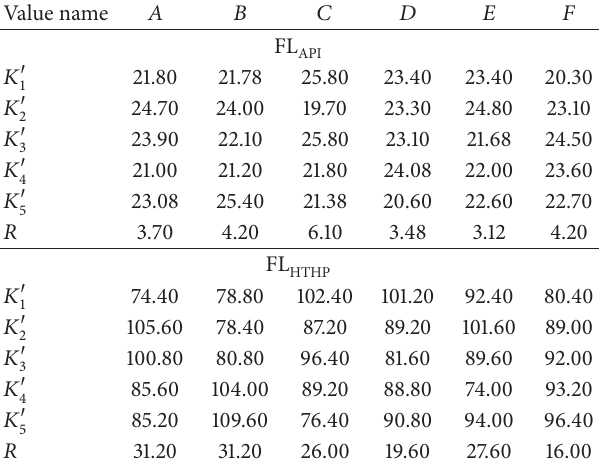
and FL . API HTHP